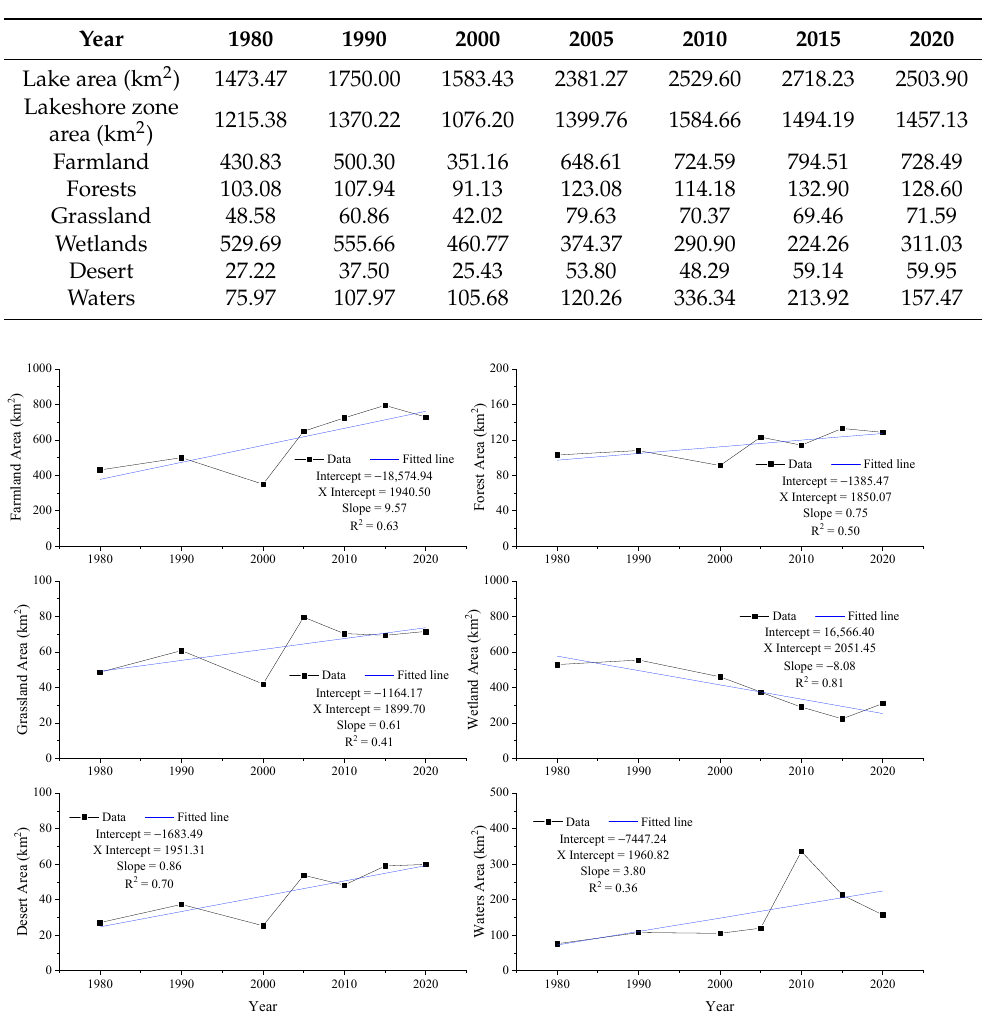
Table 3. The values of the lake area of Poyang Lake and the area of the land use type of the lakeshore zone of Poyang Lake from 1980 to 2020 (km 2 ).